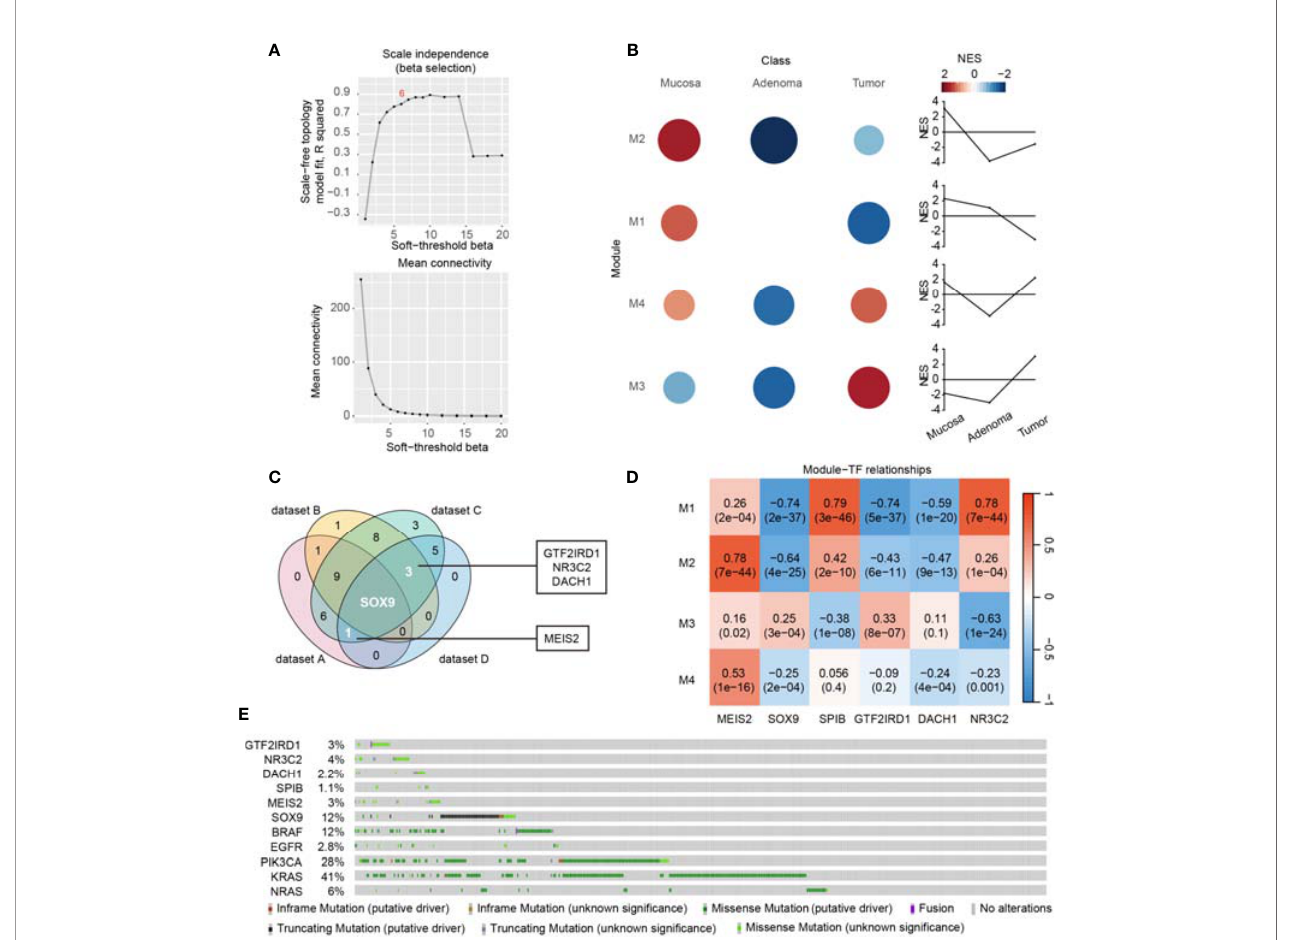
FIGURE 4 | Screening of dynamic DE-TF signature during the disease course. (A) Identi fi cation of b value based on scale-free topology and mean connectivity in CEMiTool package. (B) Signi fi cantly enriched modules and the module activity on each class of samples were shown in colored circles. Circle size is in direct proportion to the normalized enrichment score (NES). (C) Venn diagram displayed the DE-TFs commonly shared by Dataset A, C, and D, or Dataset B, C, and D. Dataset A, DE-TFs between adenoma and normal mucosa highly enriched in GO-BPs; Dataset B, DE-TFs between carcinoma and normal mucosa highly enriched in GO-BPs; Dataset C, DE-TFs signi fi cantly correlated with co-expression Module 1-4; Dataset D, DE-TFs of signi fi cance to overall survival; (D) The correlations between Module 1 - 4 and six-TF signature genes were determined by WGCNA package. The correlation coef fi cients and P values were displayed in a heatmap. (E) Mutation landscapes of six-TF signature genes and several well-known oncogenes, including BRAF, EGFR, PIK3CA, KRAS, and